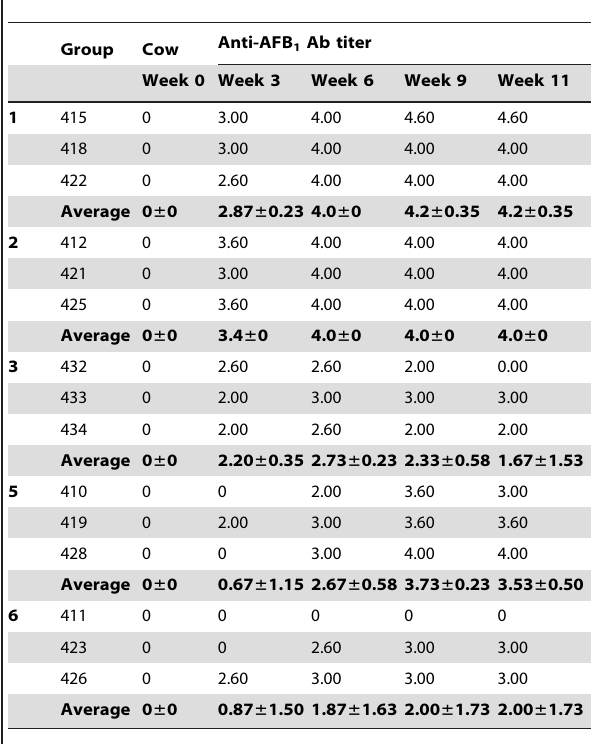
Table 2. Anti-AFB 1 Ab titers in vaccinated heifers.